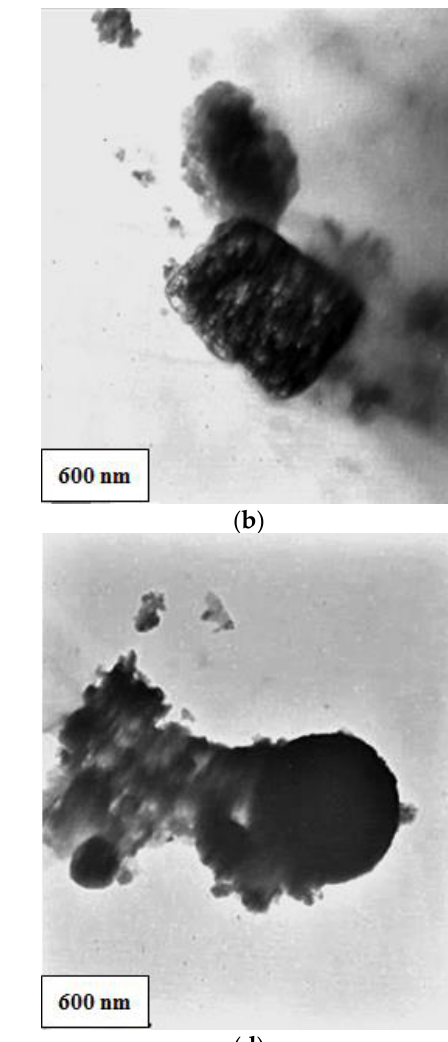
Figure 7. Micrograph by TEM for red mud: ( a ) particle that resembles a hexagon; ( b ) particle that resembles a rectangle; ( c ) and ( d ) nanoparticle agglomerate.